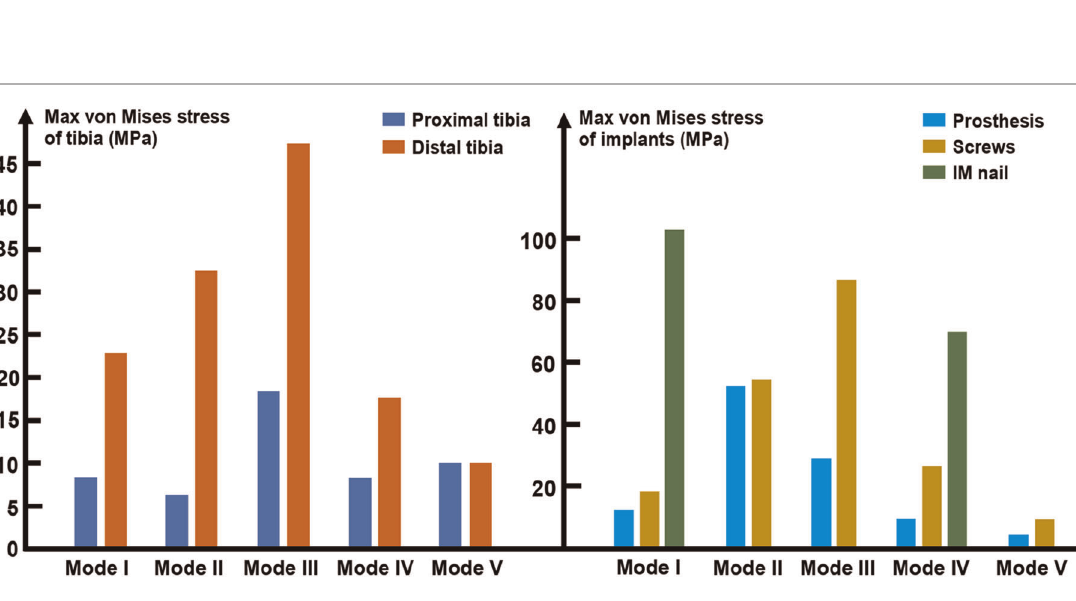
FIGURE 11 Diagram of the maximum von Mises stress of the tibia and implants (IM: